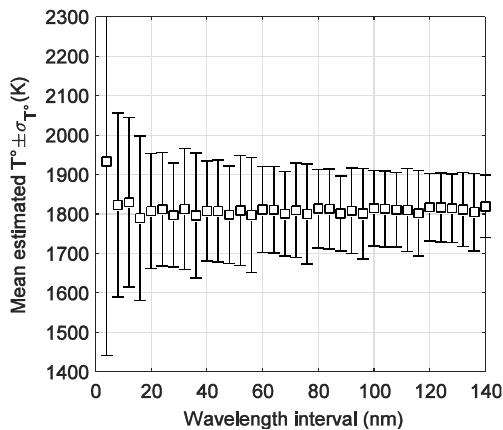
Figure 5. Mean estimated temperature by using two wavelength method and standard deviation as a function of wavelength interval ∆ λ .